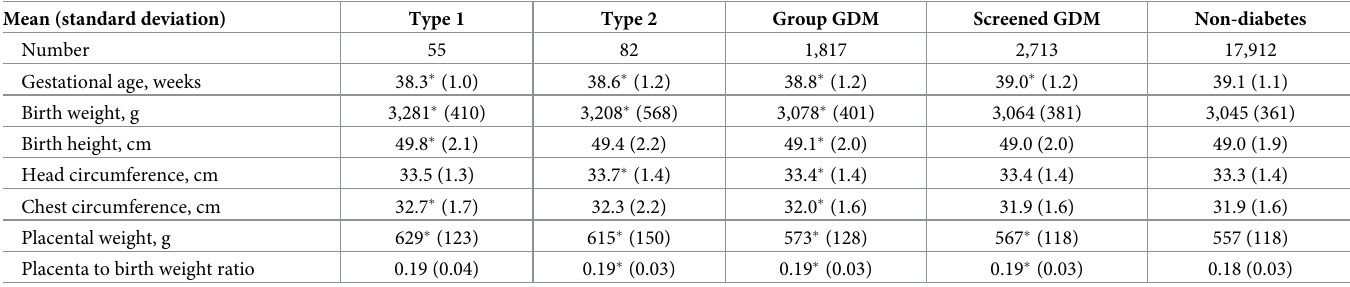
Table 5 shows gestational age and anthropometric measures in term and single births. The mean gestational age was significantly shorter and the mean birth weight was significantly higher in any of the diabetes groups than in the non-diabetes group (all p < 0.05). The mean Table 5. Perinatal data of neonates of mothers with various types of diabetes in relation to term and single births. Mean (standard